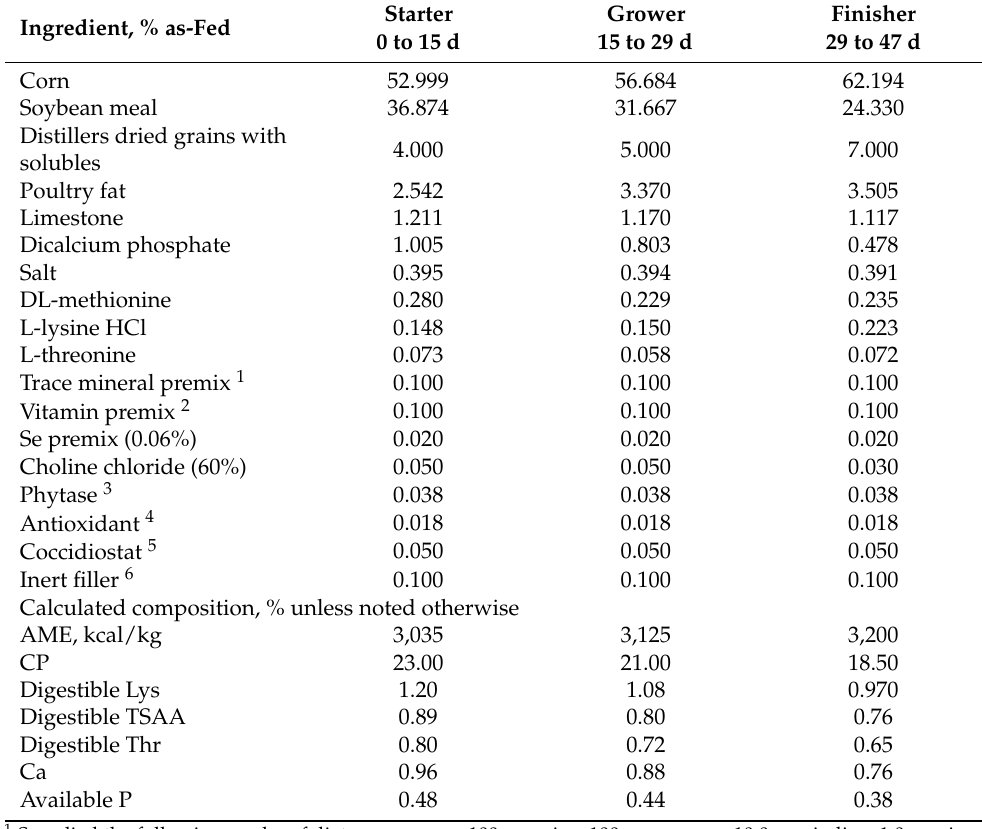
Table 1. Ingredient and calculated composition of basal